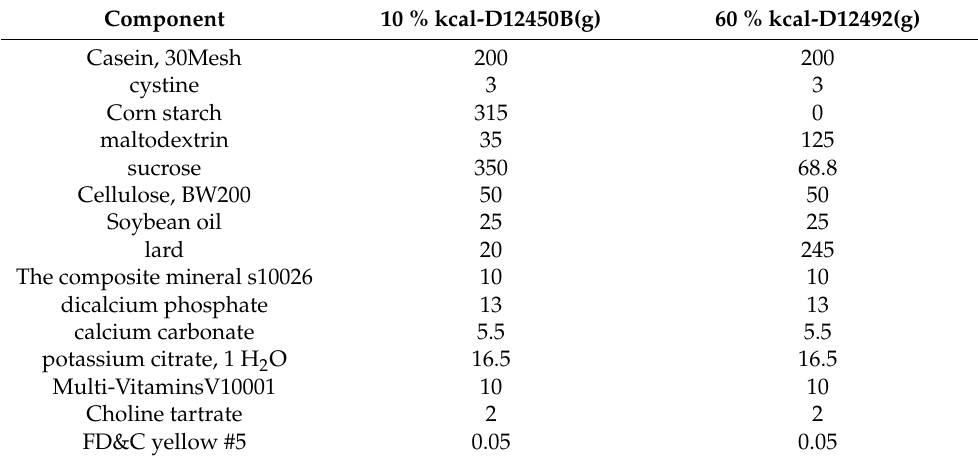
Table 1. Composition of the D12450B and D12492 diets (total calories were 4057 Kcal). Component